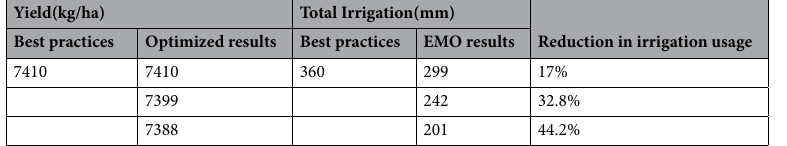
Table 2. Comparison of best simulated irrigation experimental results (ranked by yield) and the best practices.